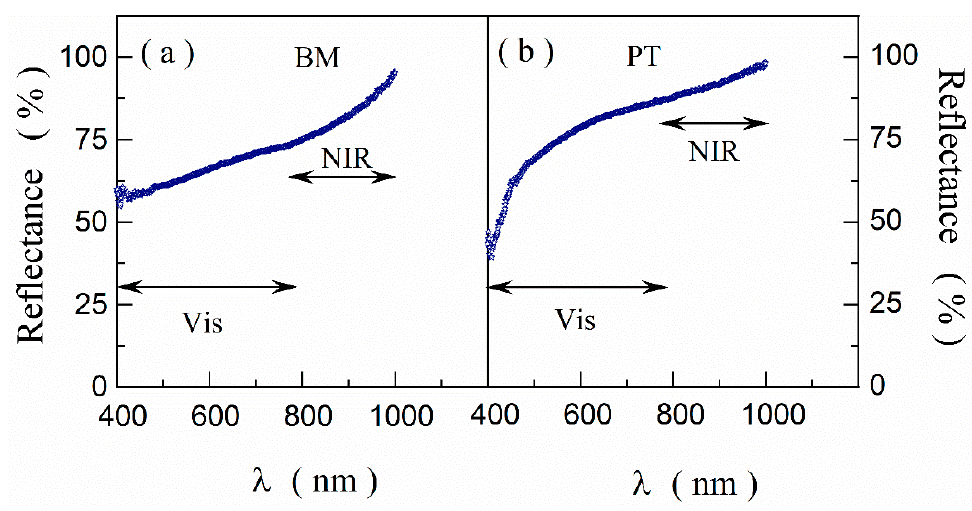
(Figure 9a). E gap (Vis) = 2.45 eV was estimated in the case of the reference PT compound